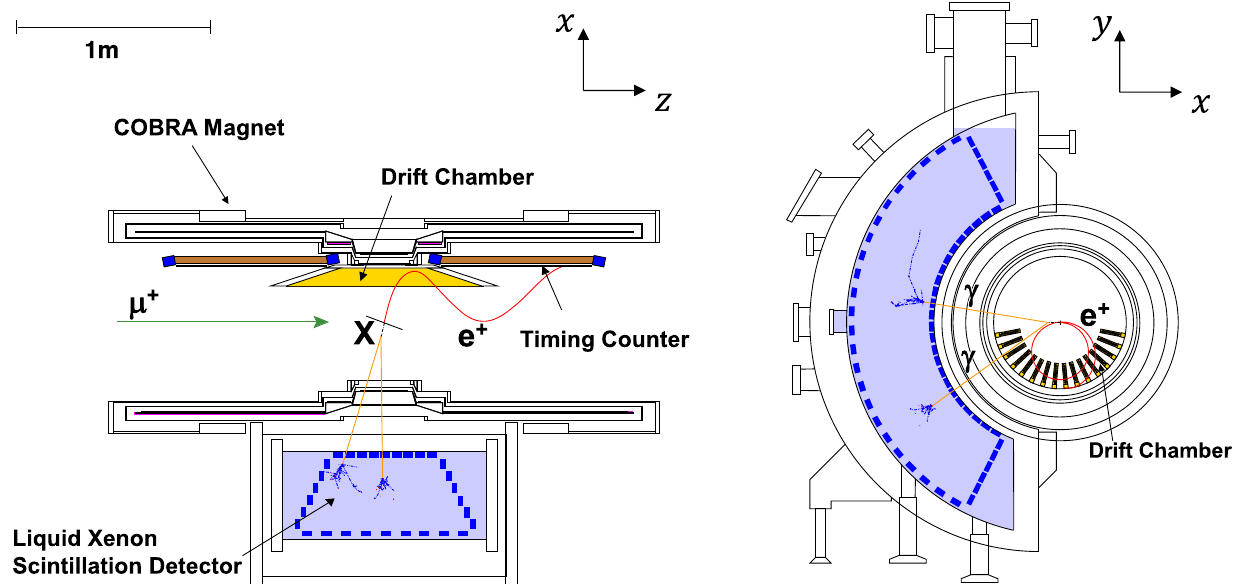
Fig. 4 The figure shows a schematic view of the MEG detector with a simulated MEx2G event emitted from the target. The top view is shown on the left, the view from downstream on the right